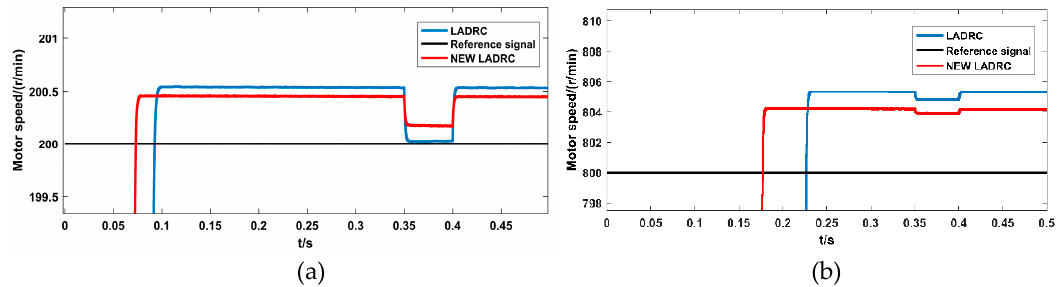
Figure 17. Sudden load increase and decrease of the motor at different speeds.